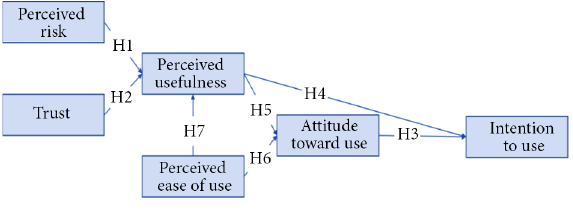
Figurе 3. Rеsеаrch